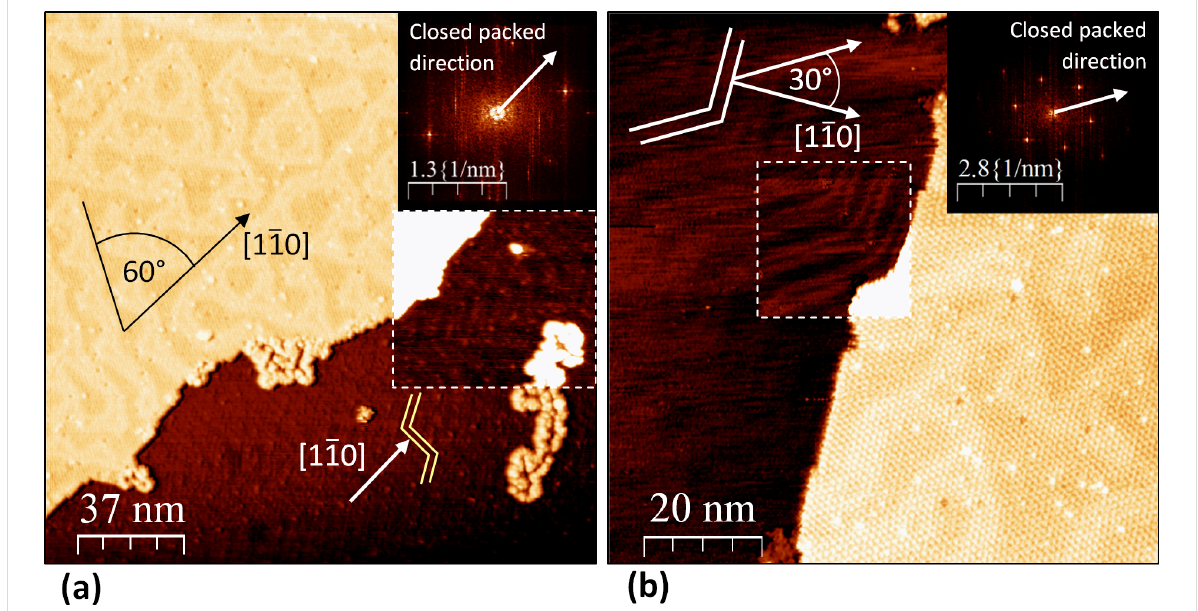
Figure 3: The Er 3 N@C 80 -monolayer orientations on Au(111) and the new interfacial reconstruction are depicted on these constant-current-images ( U = 1.5 V; I = 0.2 nA). In Figure (a) the monolayer with in-phase orientation can be seen at the left upper half of the image. The arrows on the real- space image visualize the -direction determined by the highlighted herringbone reconstruction (changed-contrast-inset and yellow double-line). The closed packed direction of the fullerenes is shown by an arrow inside the FFT-image (upper right corner) and corresponds to the Au(111)- - direction. The double line pattern of the interfacial reconstruction is visible on the monolayer. The pattern is dominated by ubiquitous 60°-angles. Figure (b) shows the out-of-phase oriented Er 3 N@C 80 -monolayer (right half) on Au(111). The closed packed direction of the molecules reveals a 30°-angle to the -direction as described by the arrows inside the FFT-image (upper right corner) and the real space